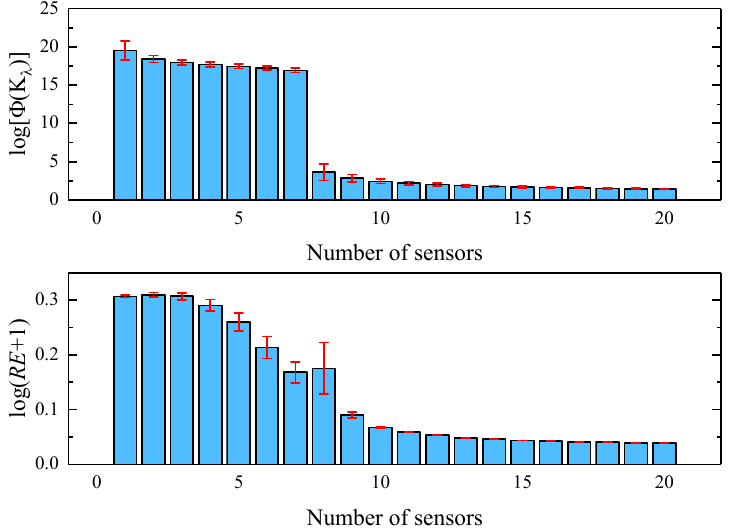
Figure 18. The average and variance (red bars) over 1000 trials of logarithm of the condition number of K λ and relative errors (pressure field).